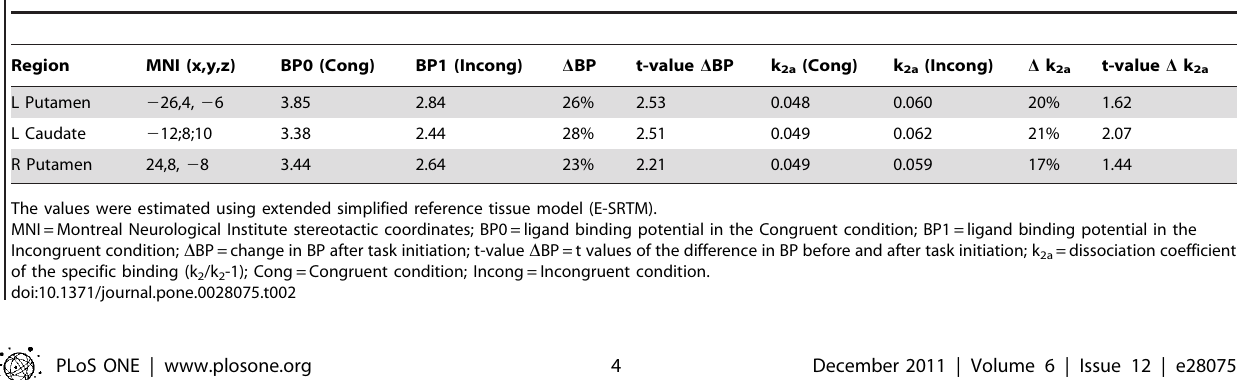
The values were estimated using linear extension of simplified reference region model (LE-SRRM).